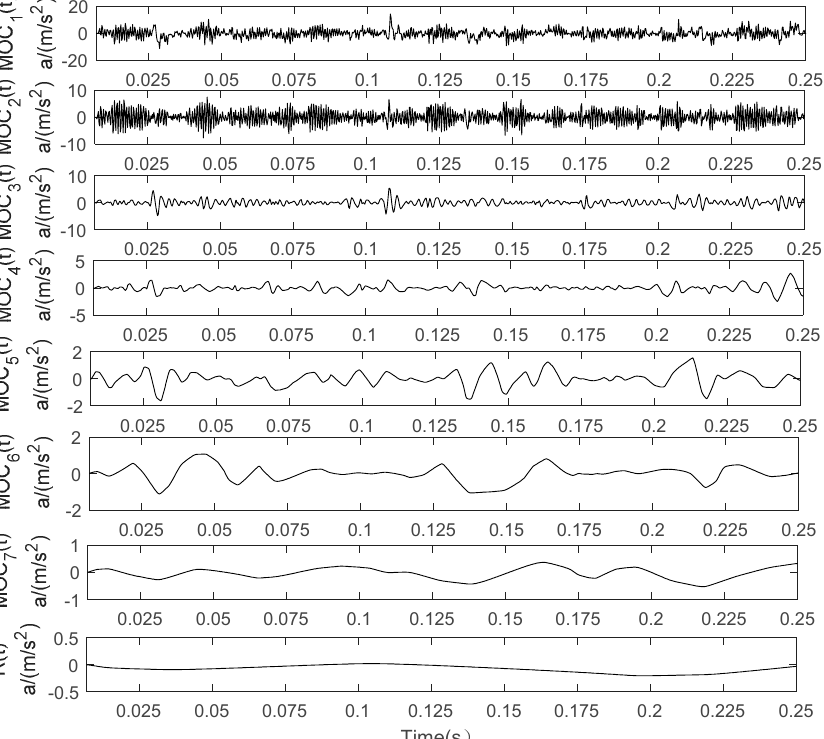
Figure 12. The decomposition results of the RS-LOD method on the rolling bearing outer-race fault signal ( p = 10).